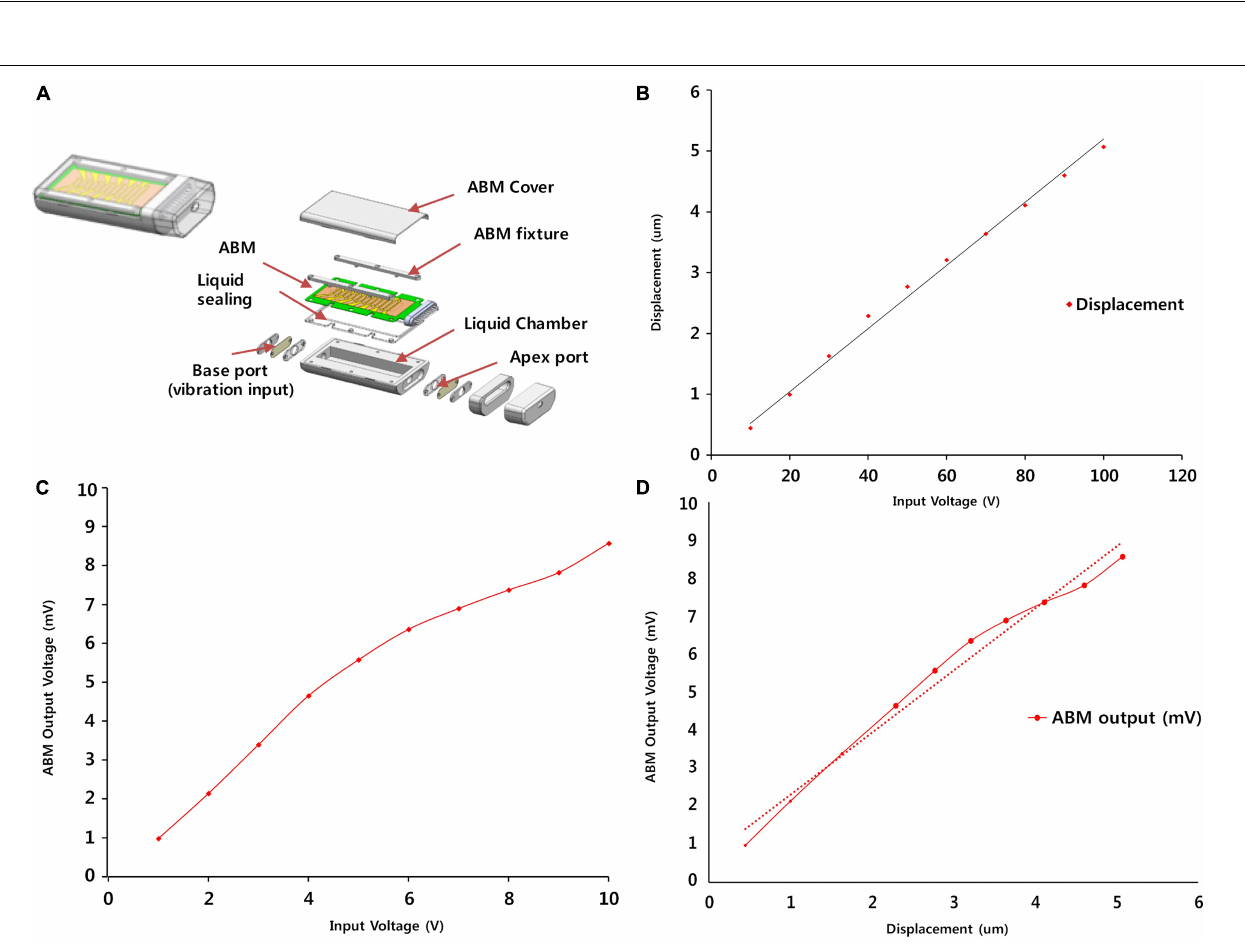
FIGURE 1 | A schematic drawing of the entire ABM system. (1) The sound vibrates the ossicle which activates the connected ABM, (2) The ABM converts the ossicular vibration into electrical output, (3) The output from ABM is amplified and modified by the electronic module, (4) The signal transmitted to the electrode stimulates the auditory nerve. A red arrow indicates the direction in which the signal goes.